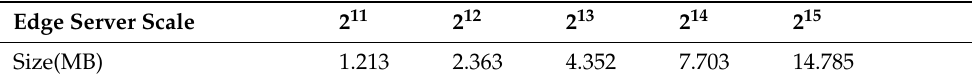
Table 5. Cumulative SCST Size.